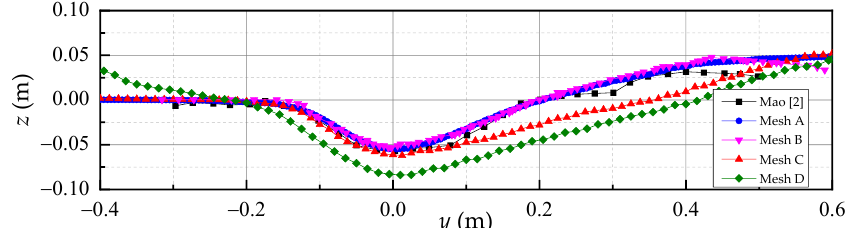
Figure 2. The numerical results of scour hole profile with different mesh levels ( t = 370 min).